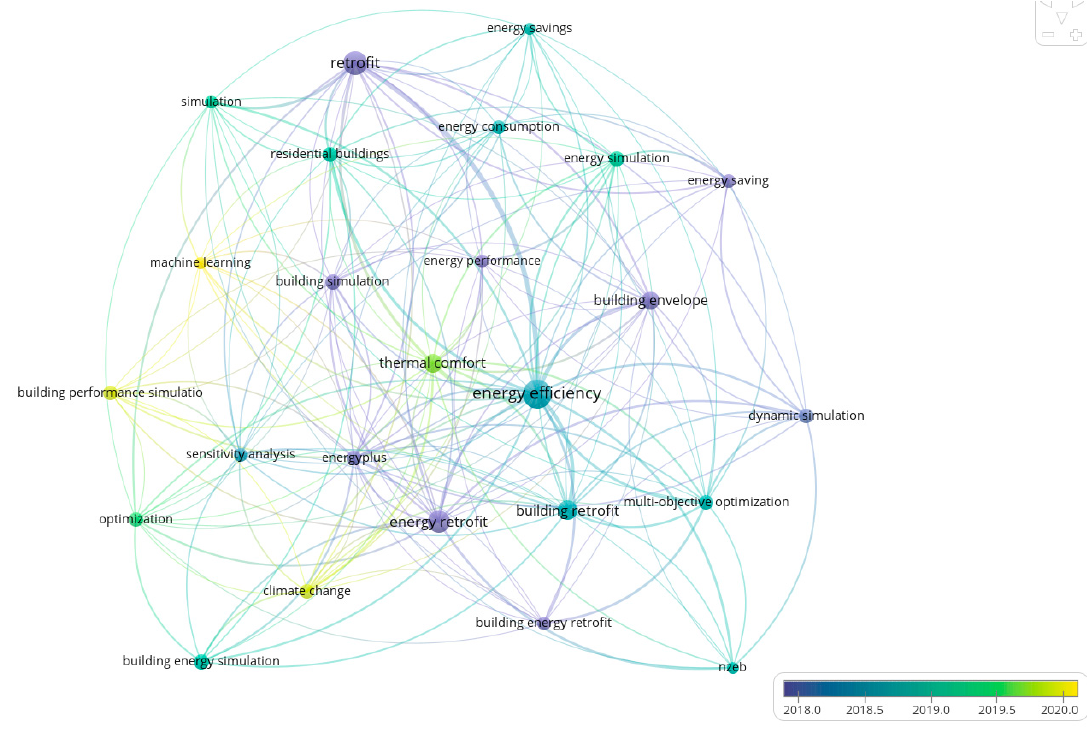
Figure 9. The publication years for energy simulation-based articles.